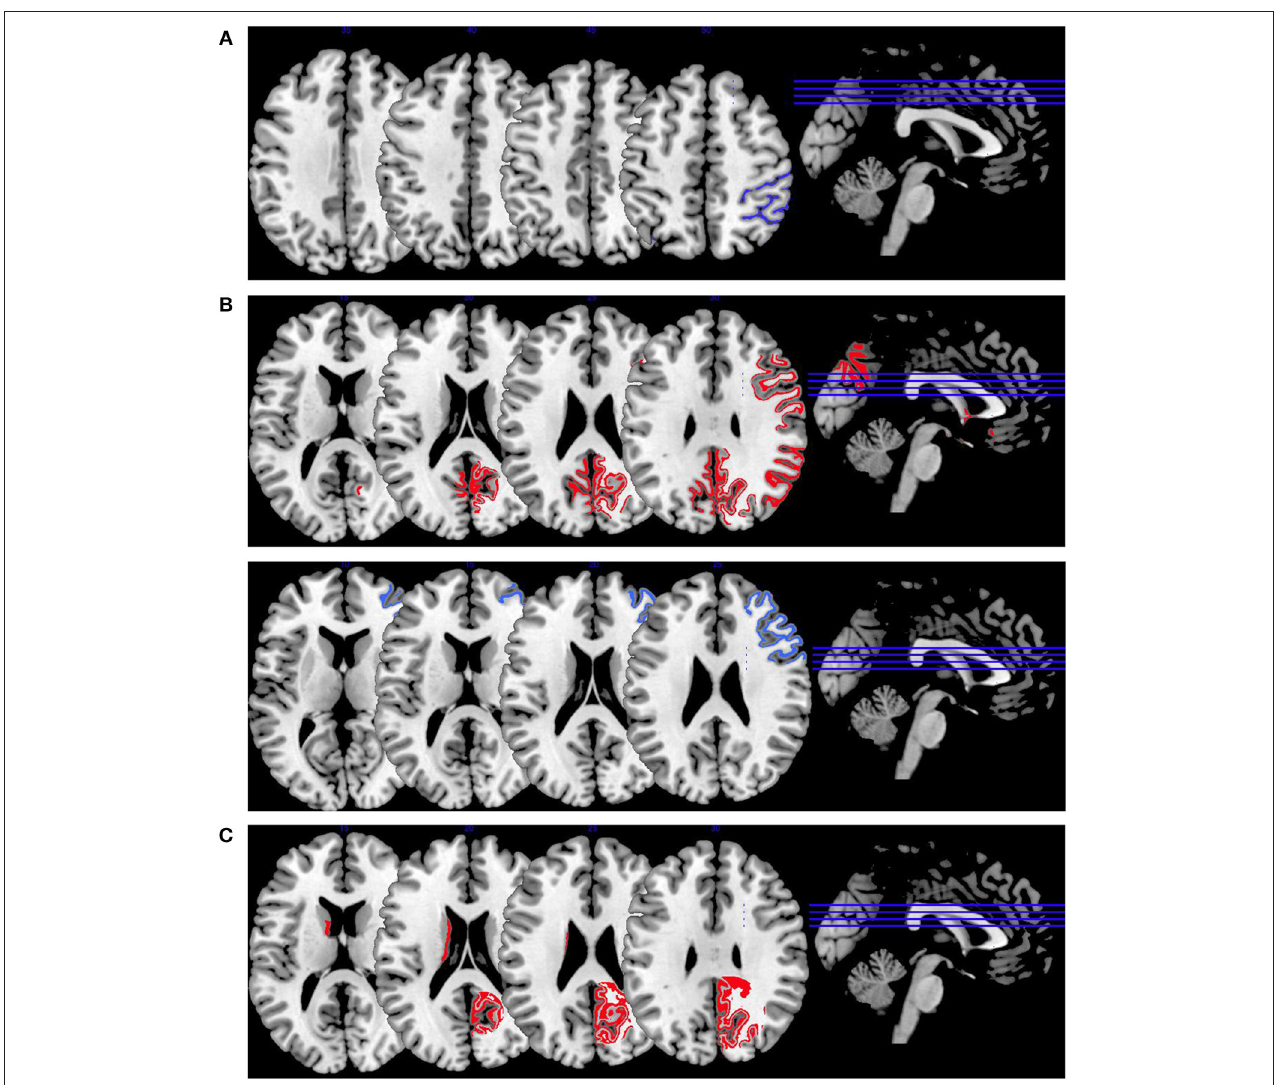
FIGURE 2 | Working memory activations. Overview of the working memory brain activation patterns reported by the reviewed studies. Hyperactivations are shown in red, hypoactivations in blue. (A) shows the activation patterns in the group comparison VS vs. NVS with VS < NVS in blue (shown slice numbers are 210, 220, 230, 240) in the contrast 2-back vs. 0-back, (B) shows the activation patterns in the group comparison VS vs. HC with VS > HC in red (shown slice numbers are 170, 180, 190, 200) in the contrasts 1- and 2-back vs. 0-back and cognitive (go/no-go task) vs. reference condition and VS < HC in blue (shown slice numbers are 160, 170, 180, 190) in the contrast NoGo20 vs. NoGo40 and NoGo40 vs. Go and cognitive (go/no-go task) vs. reference condition, (C) shows the activation patterns in the group comparison NVS vs. HC with NVS > HC in red (shown slice numbers are 170, 180, 190, 200) in the contrast 1- and 2-back vs.